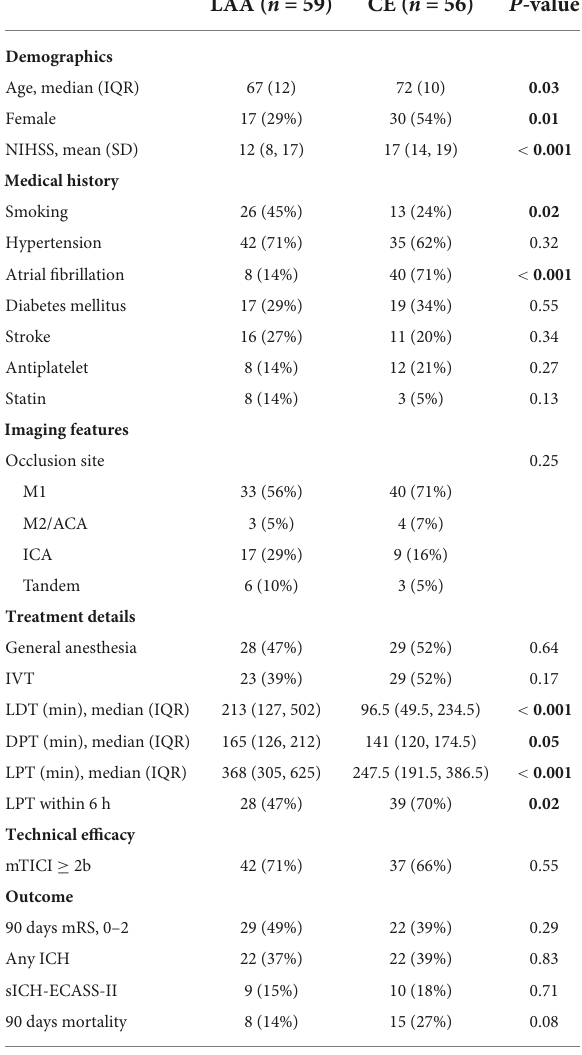
TABLE 1 Characteristics and outcomes of patients with LAA vs.